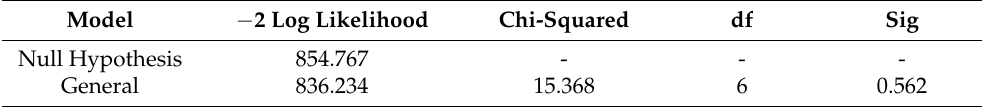
Table 8. Test of parallel